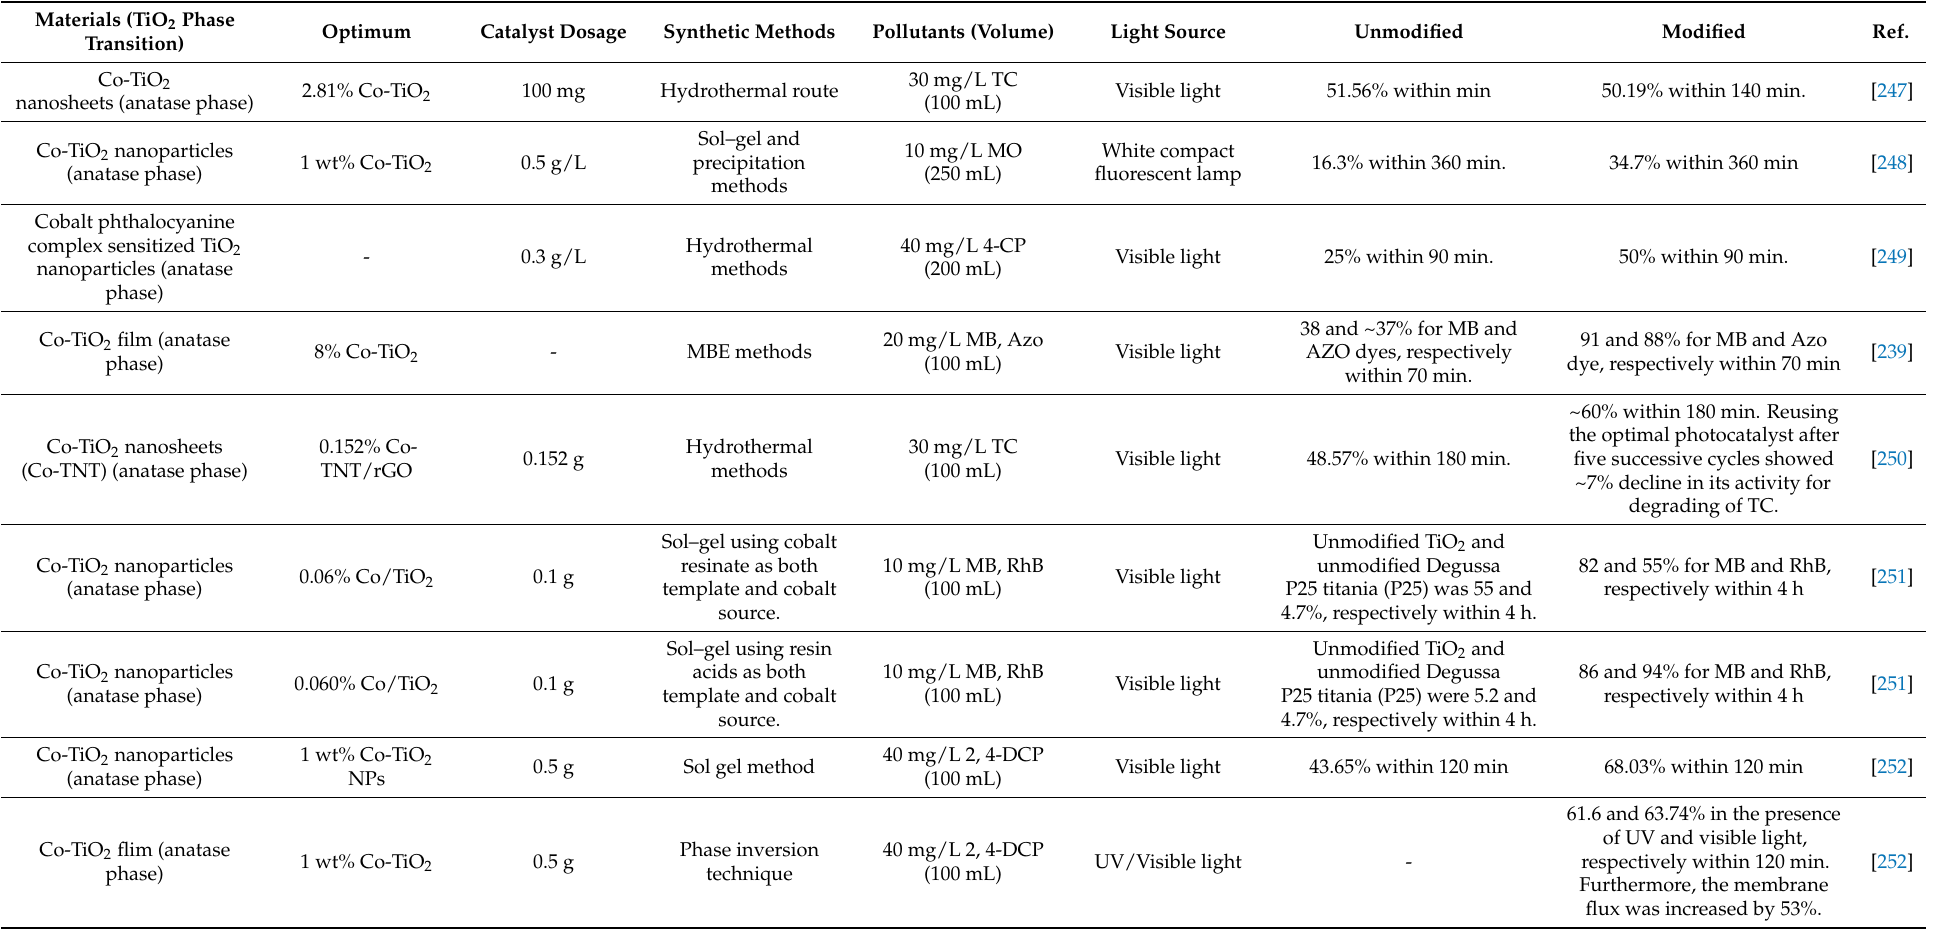
Table 11. Summary of recent progress on Co-TiO 2 photocatalysts for organic pollutants